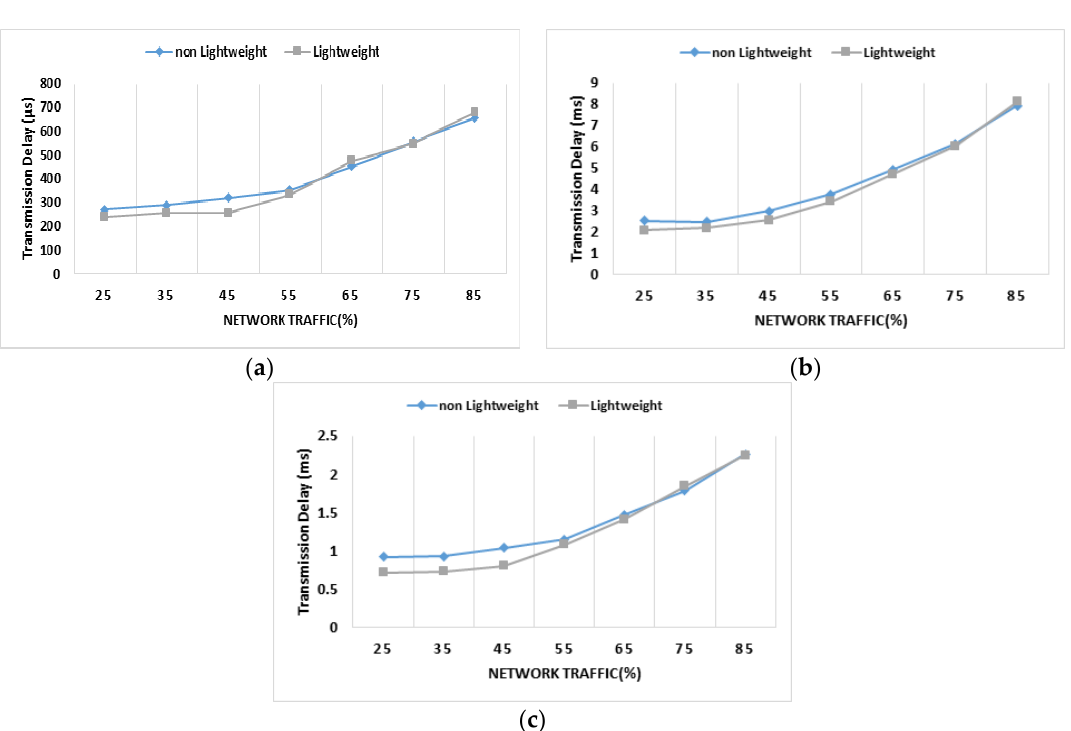
Figure 12. The transmission delay as traffic is increased. ( a ) CAN to FlexRay, ( b ) CAN to MOST, ( c ) CAN to